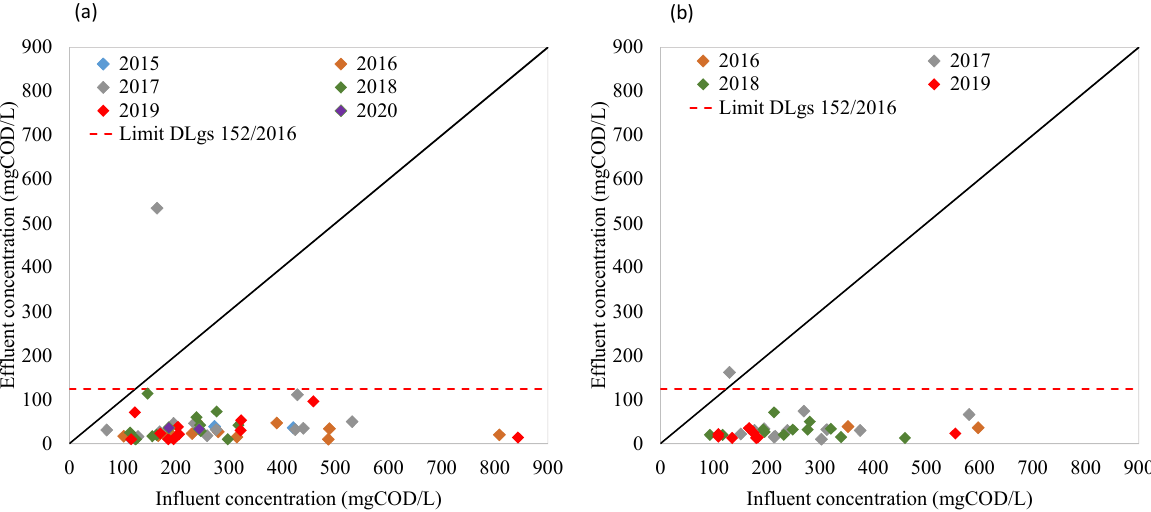
Figure 9. Influent and effluent COD concentration for the Corleone ( a ) and Marineo ( b ) WWTPs during the years 2015–2020.